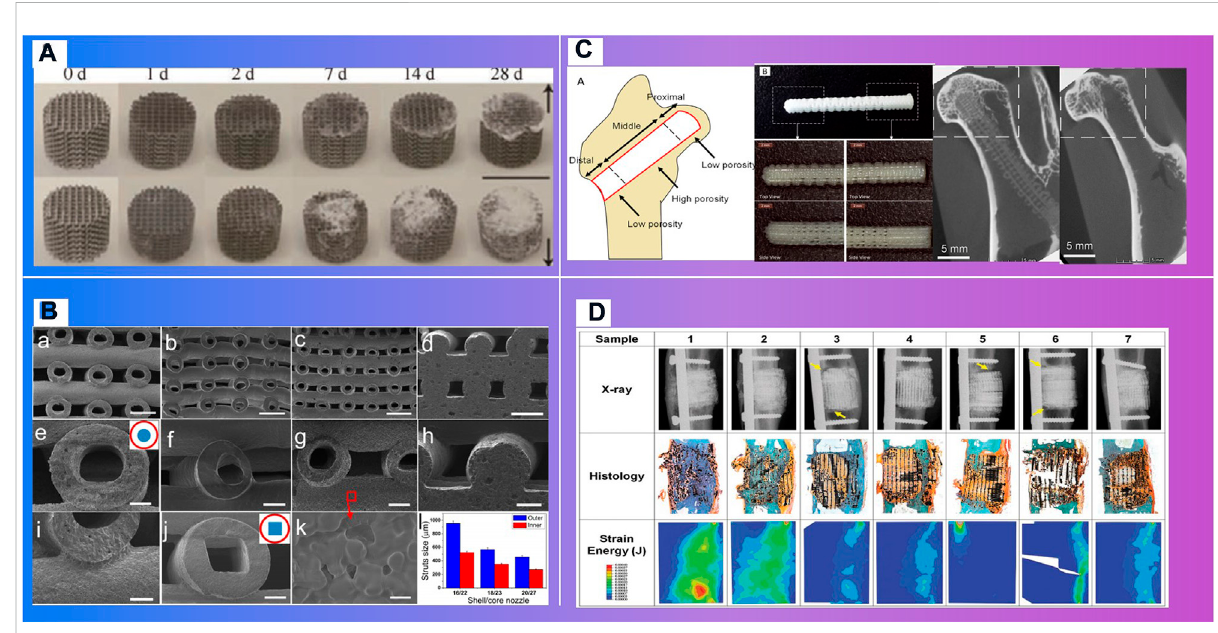
FIGURE 9 Materials with biodegradability. (A) . Degradation process (Li et al., 2020). (B) . SEM images of printed HSP bioceramic scaffolds via core/shell nozzleof16/2218/23and20/27andprintedSSPbioceramicscaffoldsasthecontrol(Luoetal.,2015). (C) .Afunctionallygradedscaffold(Kawaietal., 2018). (D) . Mathematical modeling of total strain energy for defects implanted with the Sr-HT-Gahnite scaffold at 12 months postimplantation (Li et al.,